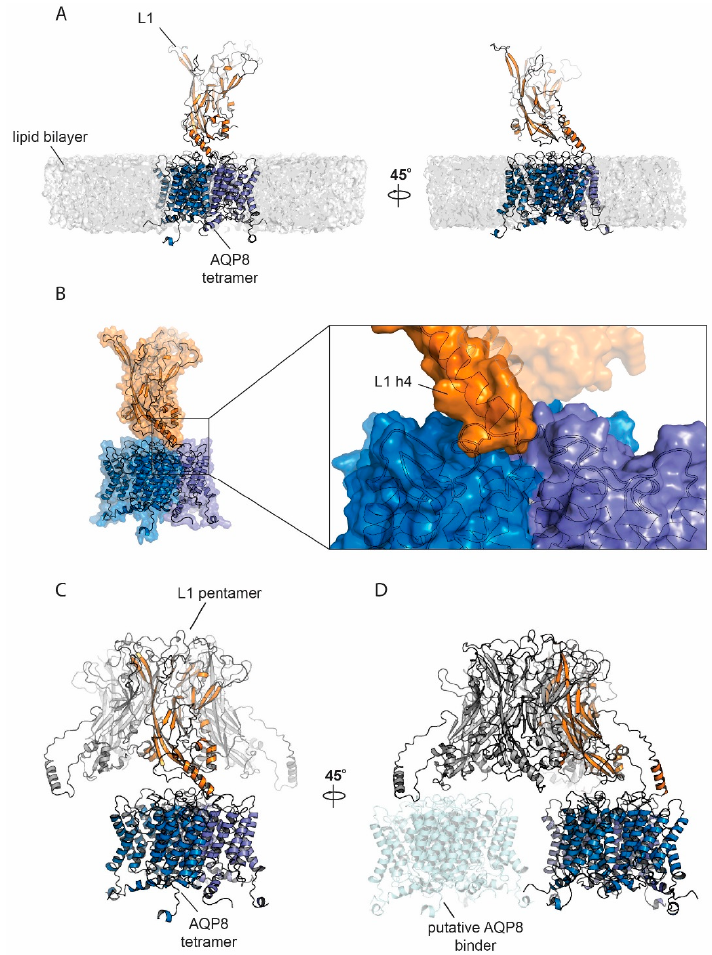
Figure 6. Cartoon representation of AQP8 model and L1 interaction. ( A ) AQP8 model (each monomer is colored in a different shade of blue) and L1 (orange) interaction represented in the presence of a lipid bilayer. ( B ) Surface representation of L1:AQP8 complex. In the box, the magnification of the interaction surface where one AQP8 monomer interacts with the L1 extended h4 helix domain. ( C ) Pentameric L1 used for docking simulations. ( D ) Possible interaction of the L1 pentamer with multiple AQP8